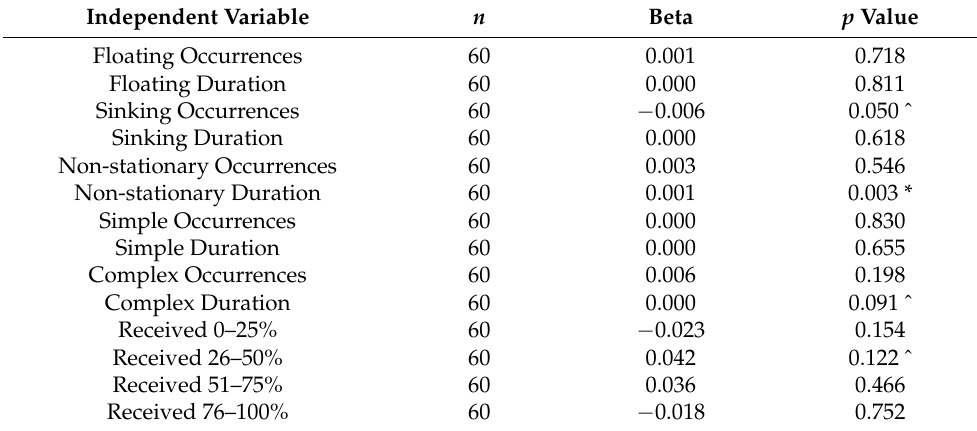
Table 3. Univariate correlations between ODBA and independent variables.